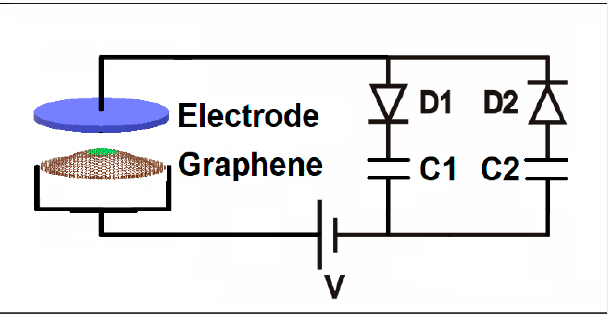
Figure 1. Graphene energy harvesting circuit using two diodes (D1 and D2), two storage capacitors (C1 and C2), and a rechargeable battery (V) to charge the graphene-electrode variable capacitor on the left.